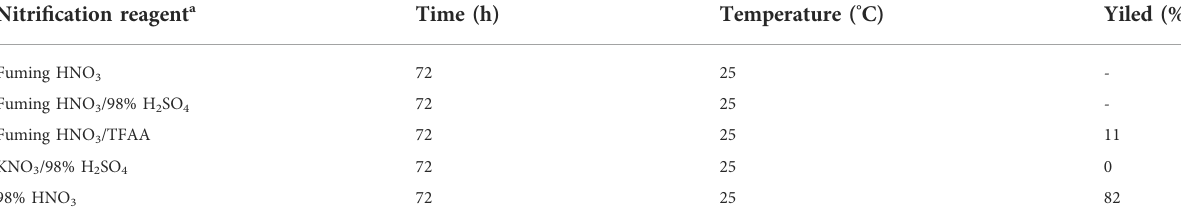
TABLE 1 Nitri fi cation reaction conditions of 4 Nitri fi cation reagent a Time (h) Temperature ( ° C) Yiled (%)